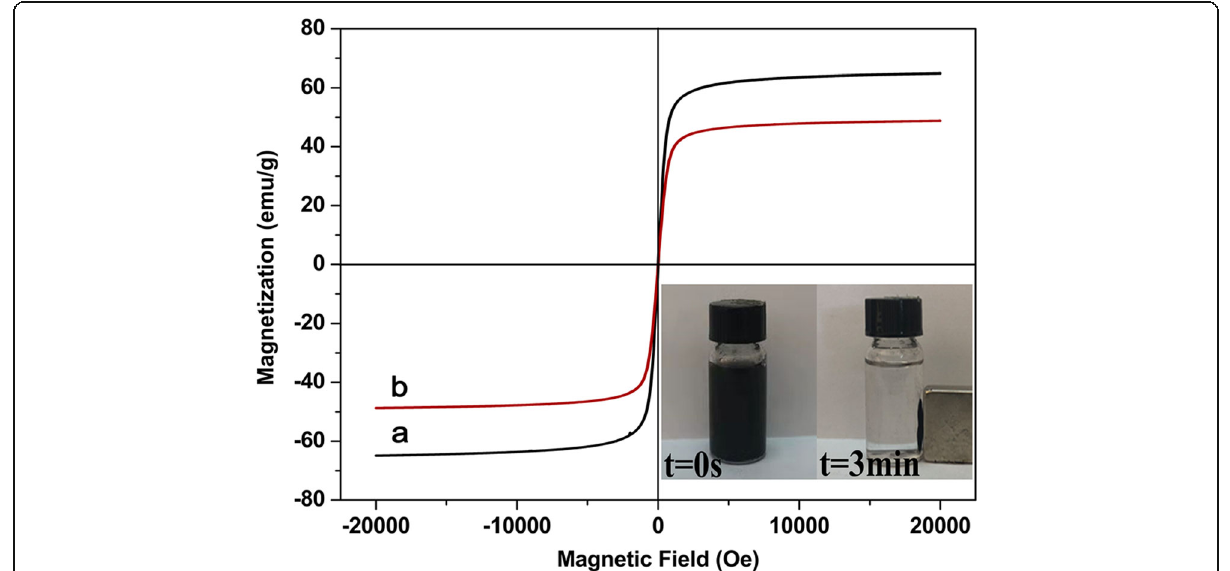
Fig. 3 Magnetization curves of a Fe 3 O 4 and b Fe 3 O 4 @PDA nanoparticles at room